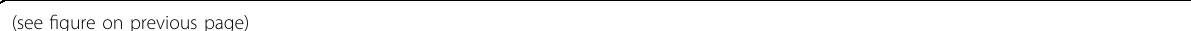
(see fi gure on previous page) Fig. 6 Exovesicular-Shh imparts Imatinib resistance. A Western blot-based analysis of the cell lysate and Exo-fraction isolated from Shh-K562 and K562. Shh, Actin (cytosolic protein), GM130 (a golgi marker), Tsg101, and Flotilin2 (exovesicle markers) analyzed. Data from two to three biological repeats each. B Western blot evaluating relative levels of Shh in Exo and free-fractions derived from Shh-K562 and K562 condition media. Equal total protein loaded in each well for analysis ( n = 4). C Western blot representing presence of Shh in extracellular fractions Exo and free-fractions derived from BM sample from CML patient (CML12, CML-variant). Different concentrations of total protein were loaded per well to evaluate relative enrichment of Shh in each fraction, as indicated. Graph represents densitometric estimation of relative protein levels normalized to total amount of protein loaded per well. D ’ Schematic represents the assay procedure using conditioned medium. D Bar graph represents viability of K562 cells pretreated with Exo-fraction or free-fraction derived from K562 or Shh-K562 (12-h pre-treatment), followed by treatment with 0.5 µM Imatinib for 72 h. Imatinib-treated K562 cells (black bar) and Shh-K562 cells (green bar) used as negative and positive controls, respectively. Bar represents mean ± SD from three different experiments. E ’ Schematic represents the assay procedure using BM plasma. E Bar graph represents viability of K562 cells after 12-hr pre-treatment with Exo or free-fraction derived from CML patients BM (red bar, V-CML; CML-4, 9, 12) ( n = 3); gray bar, CML-CP (9:22; CML-1, 3, 8) ( n = 3), followed by treatment with 0.5 µM Imatinib for 72 h. Imatinib-treated K562 cells (black bar) and Shh-K562 cells (green bar) used as negative and positive controls, respectively. Data represent mean ± SD from three different CML patient-derived fractions. P values, *<0.05, **<0.01, and ***<0.001. Statistical analysis done using t